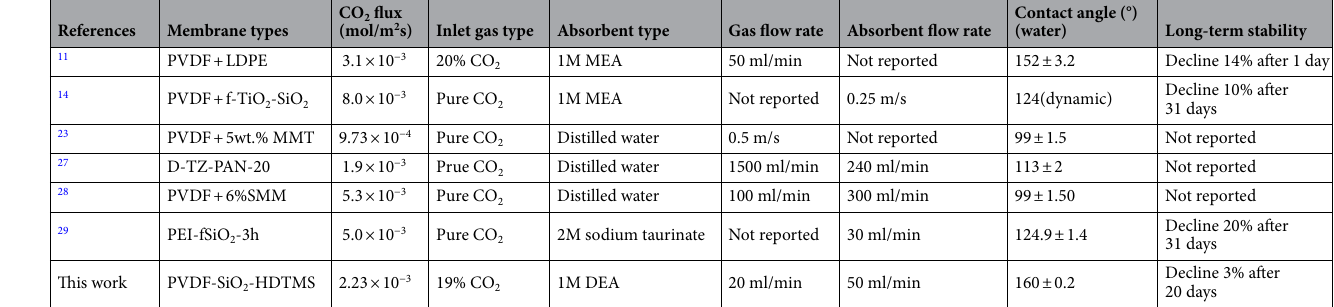
Table 6. Comparison of CO 2 absorption performance in gas–liquid membrane